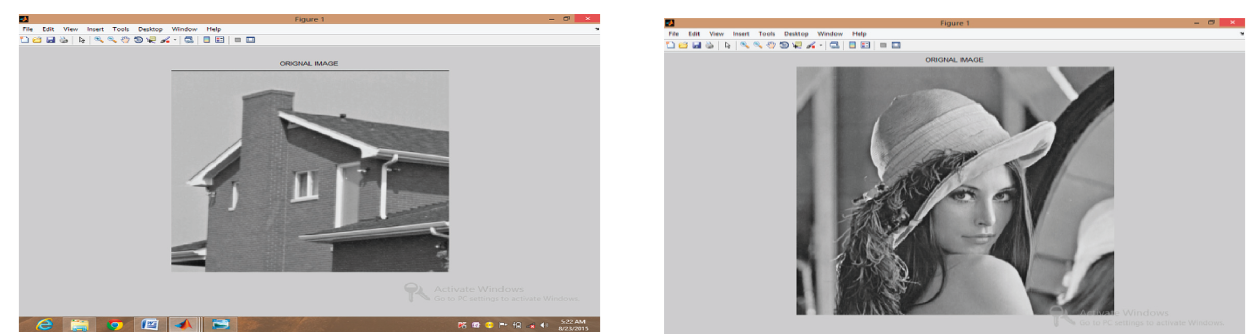
Figure 15: Original image of house.